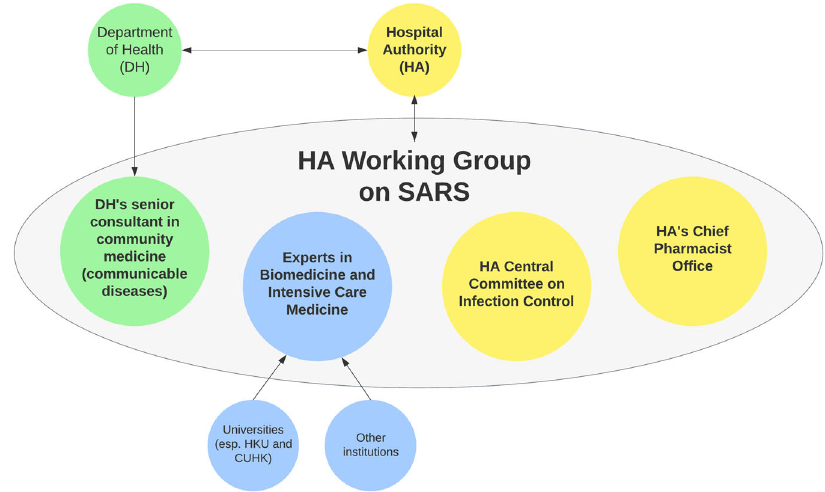
Fig. 1 The core decision making and reporting entities in response to SARS. Hong Kong ’ s scienti fi c advisory board for SARS was established under HA, which managed public hospitals and healthcare provision, instead of under DH, which communicated and coordinated with the local government and industry groups, as well as Mainland Chinese and international